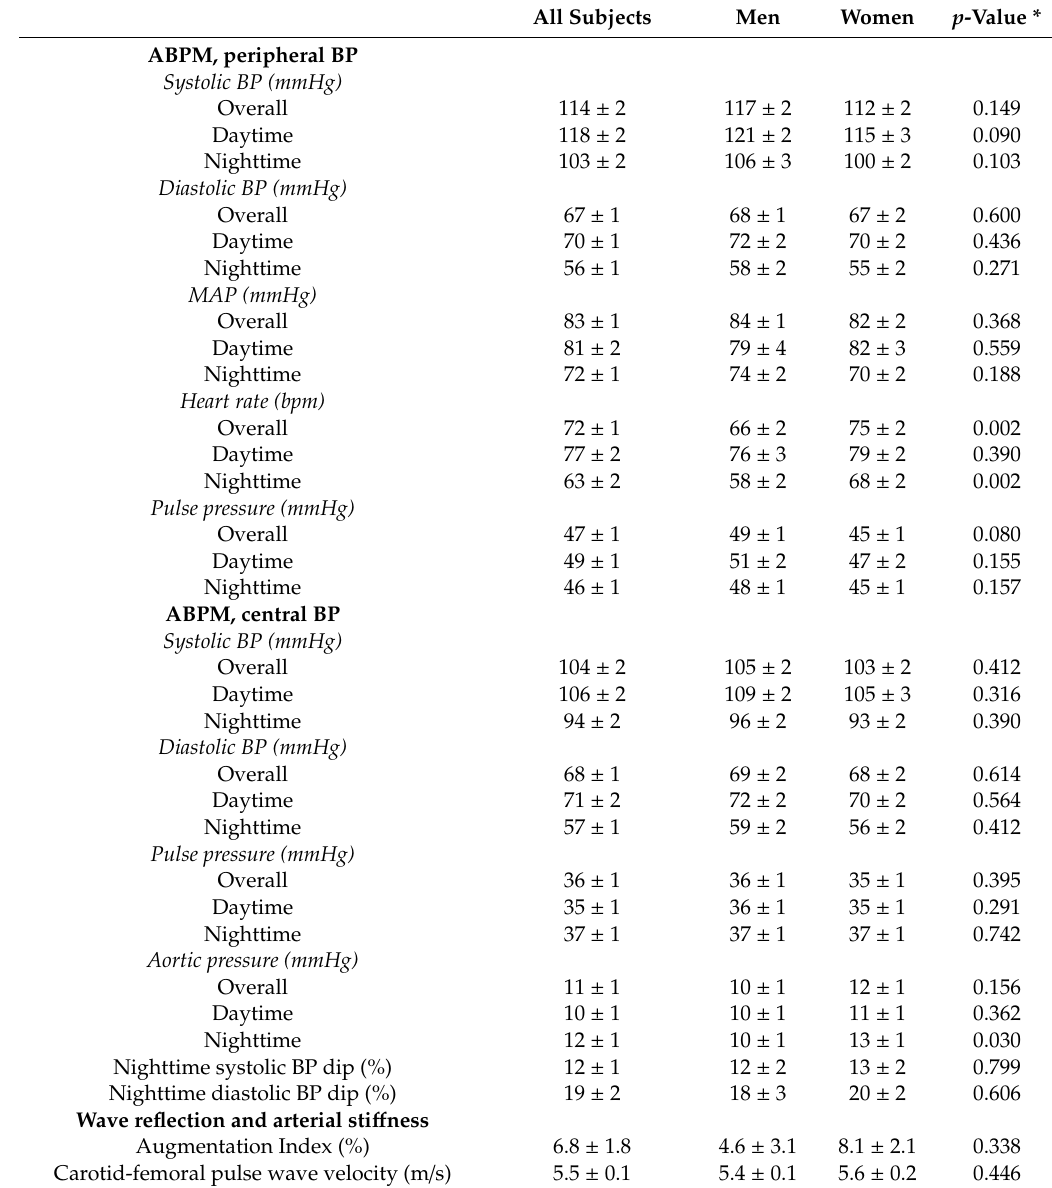
Table 2. Ambulatory blood pressure and vascular data.